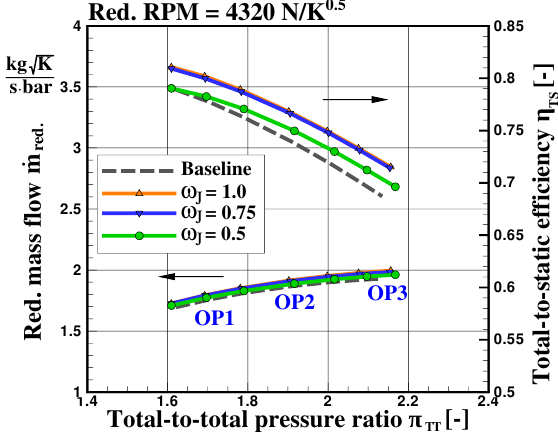
Figure 5. Performance map of the baseline and the optimized designs by using different weights ω J in the weighted objective